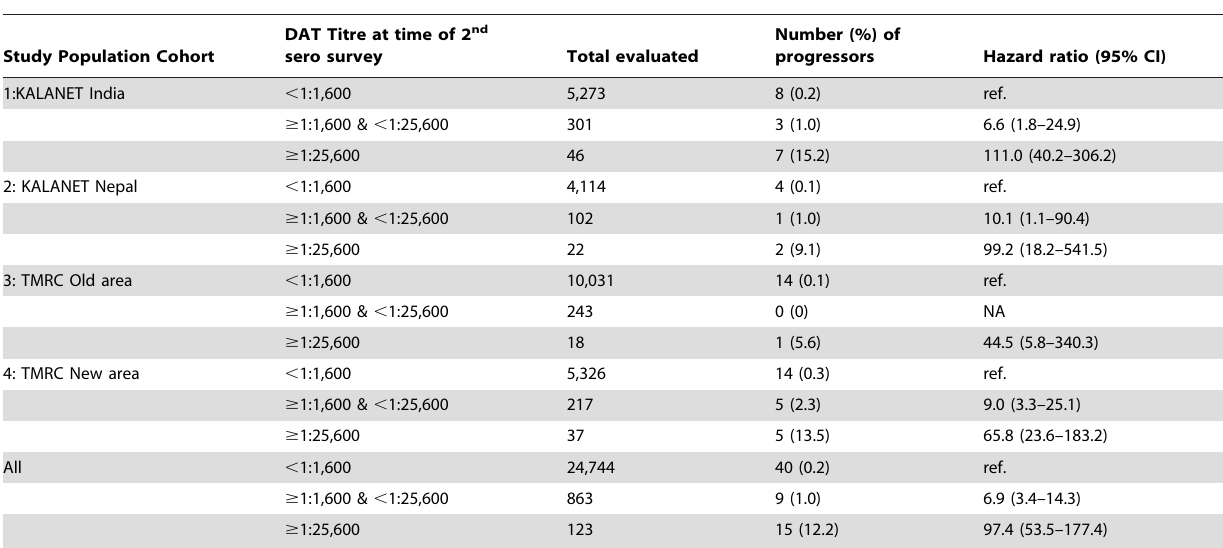
Table 4. Risk of progression to symptomatic VL among individuals who seroconverted according to their DAT titer, compared to individuals who did not